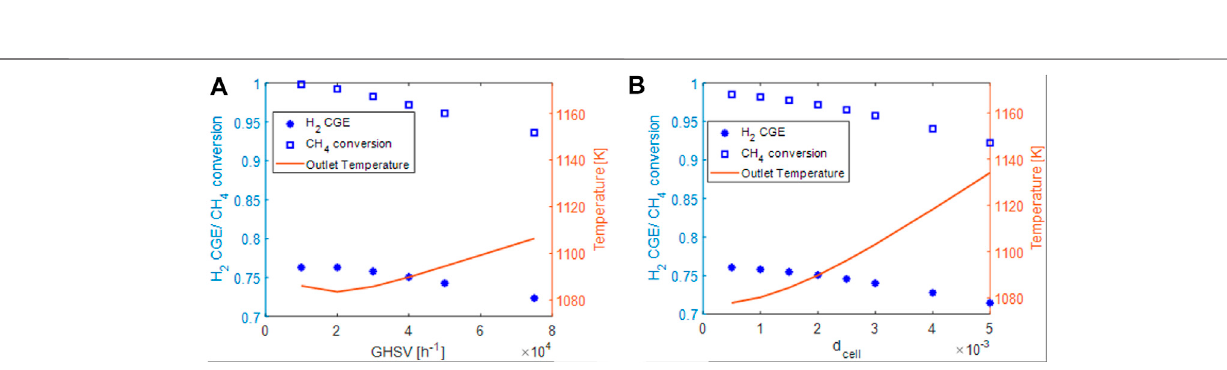
Frontiers in Chemical Engineering |